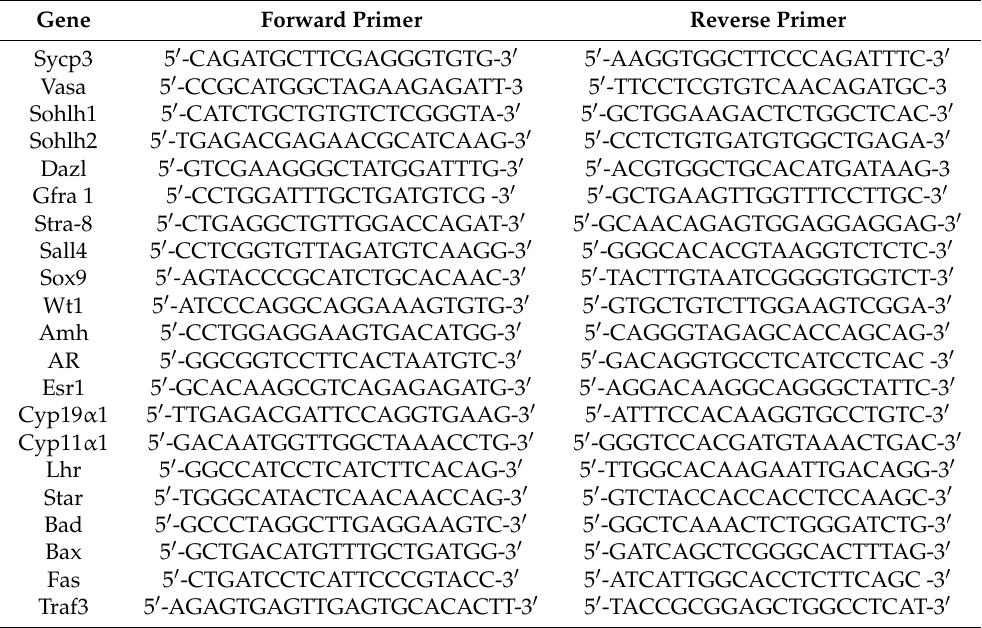
Table 2. Primers used for reverse-transcription polymerase chain reaction using mouse cDNA.